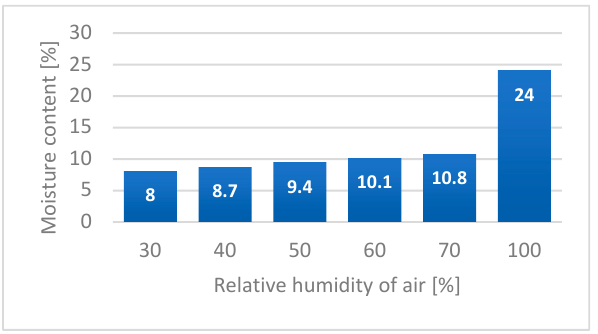
Figure 15. Effect of relative humidity of air on moisture content of hemp fibres based on [51].